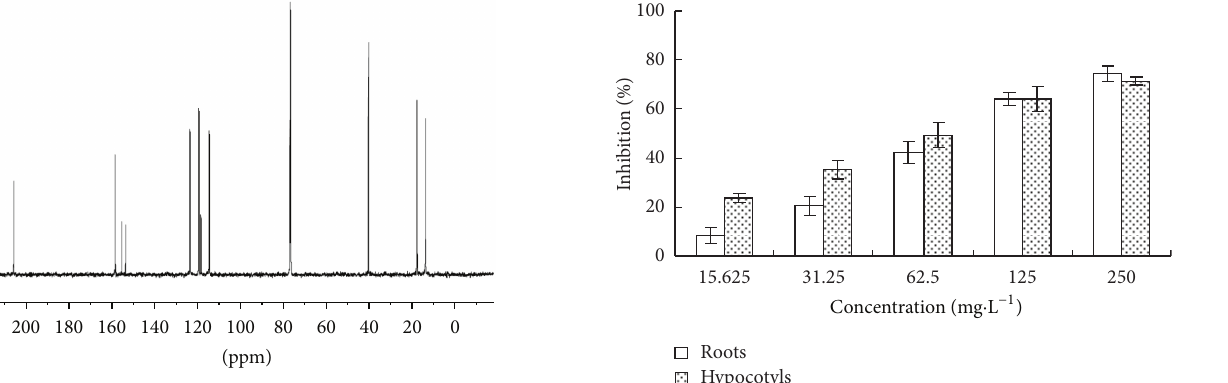
Figure 3: Bioassay of 5-fluoro-2-hydroxy butyrophenone on the seedling growth of Lactuca sativa L.